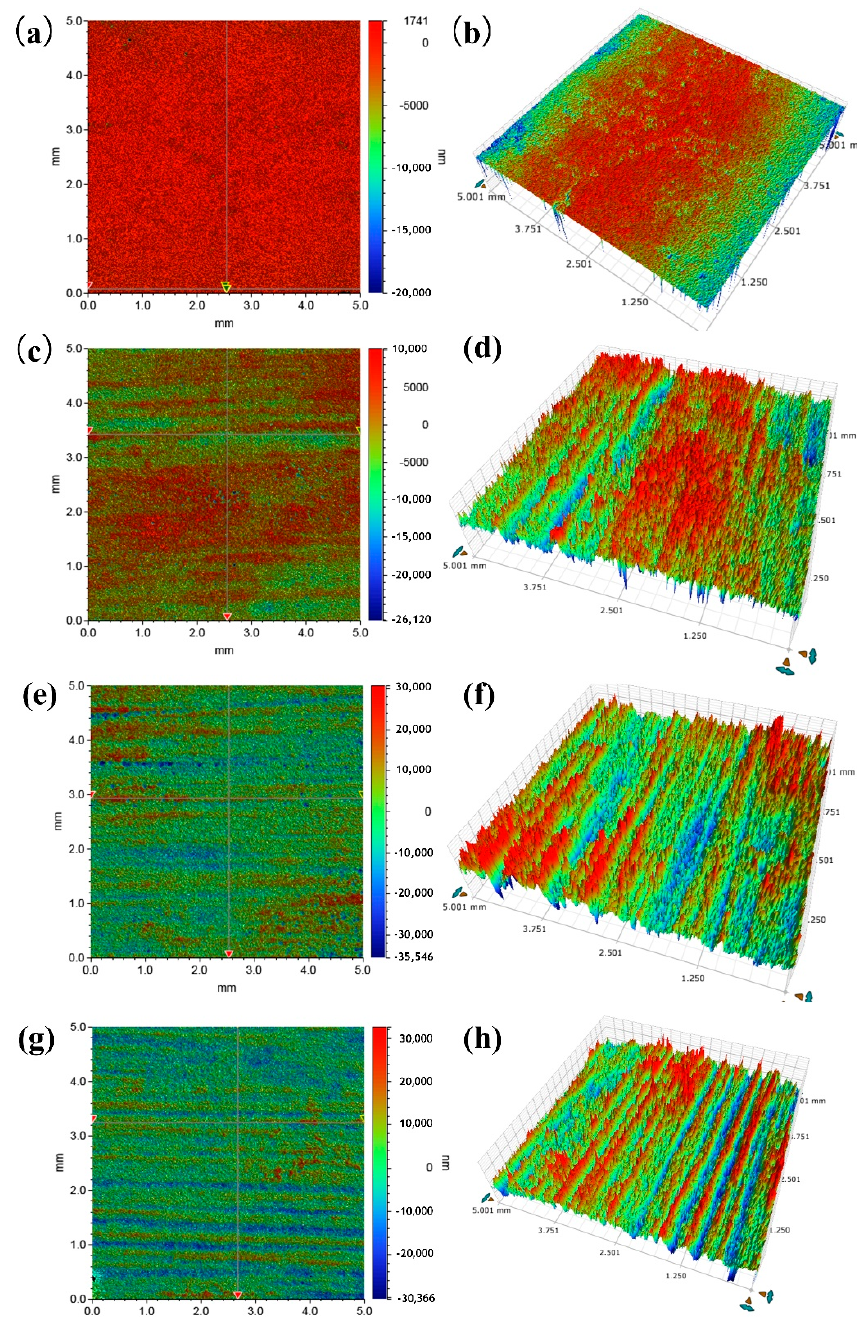
Figure 13. ( a ) The plan image and ( b ) stereogram image of surface morphology after 1/2 day of testing; ( c ) the plan image and ( d ) stereogram image of surface morphology after 2 days of testing; ( e ) the plan image and ( f ) stereogram image of surface morphology after 4 days of testing; ( g ) the plan image and ( h ) the stereogram image of surface morphology after 7 days of testing.